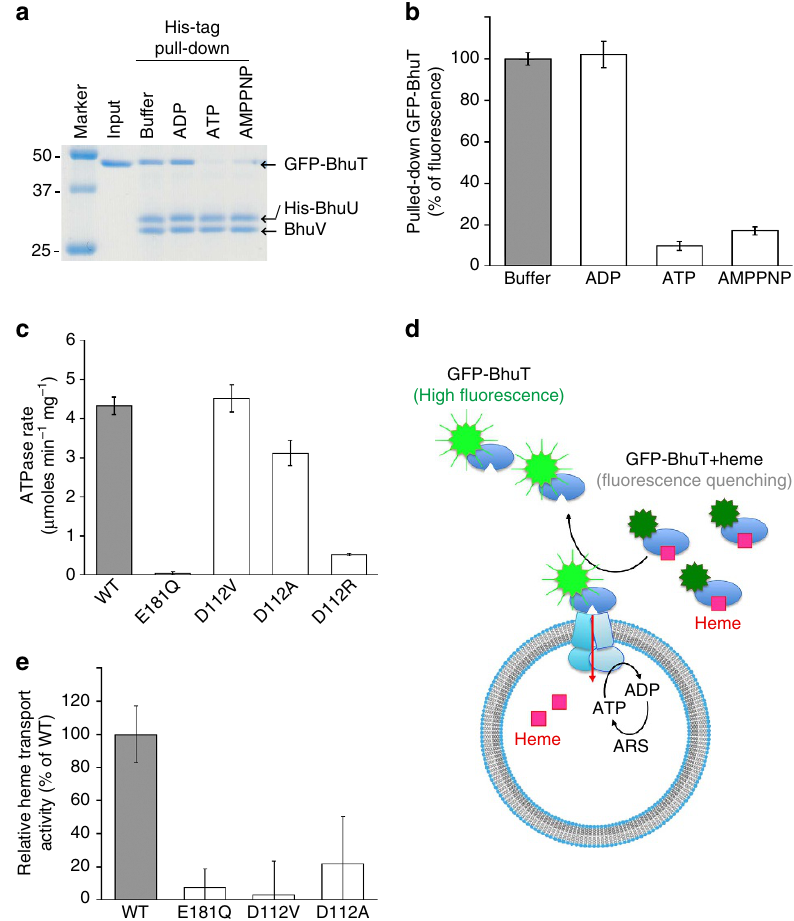
Figure 4 | Functional analysis of the haem transporter BhuUV-T. ( a ) The BhuUV–BhuT interactions were evaluated by assessing the effect of nucleotides (ADP, ATP or ATP analogue) on the His-tag pull-down. His-tagged BhuUV was immobilized on Ni-NTA agarose resin and incubated with GFP-tagged BhuT. After washing with binding buffer (lane 3), buffer containing ADP (lane 4), ATP (lane 5) or AMPPNP (lane 6), the pulled down samples were analysed by SDS–PAGE and stained with Coomassie Brilliant Blue. A representative result is shown. ( b ) The amounts of pulled down GFP-BhuT in ( a ) are expressed as the per cent fluorescence intensity relative to the control without the nucleotide. ( c ) ATPase activity of BhuUV mutants in the detergent solution was measured to evaluate the importance of D112 in the translocating channel. E181Q is an inactive mutant in which the conserved residue in the ATPase catalytic site in BhuV is mutated. D112R was unstable during the purification owing to aggregation and showed a lower ATP hydrolysis rate. ( d ) Depiction of the transport assay protocol using BhuUV-reconstituted liposome containing an ARS. The external concentration of the haem was measured by the change of fluorescence from GFP-tagged BhuT. ( e ) Comparison of the haem transport activity. The activity is expressed in terms of the percentage of wild type (100%). Reconstitution of D112R into liposome was unsuccessful. Error bars show s.d. ( n ¼